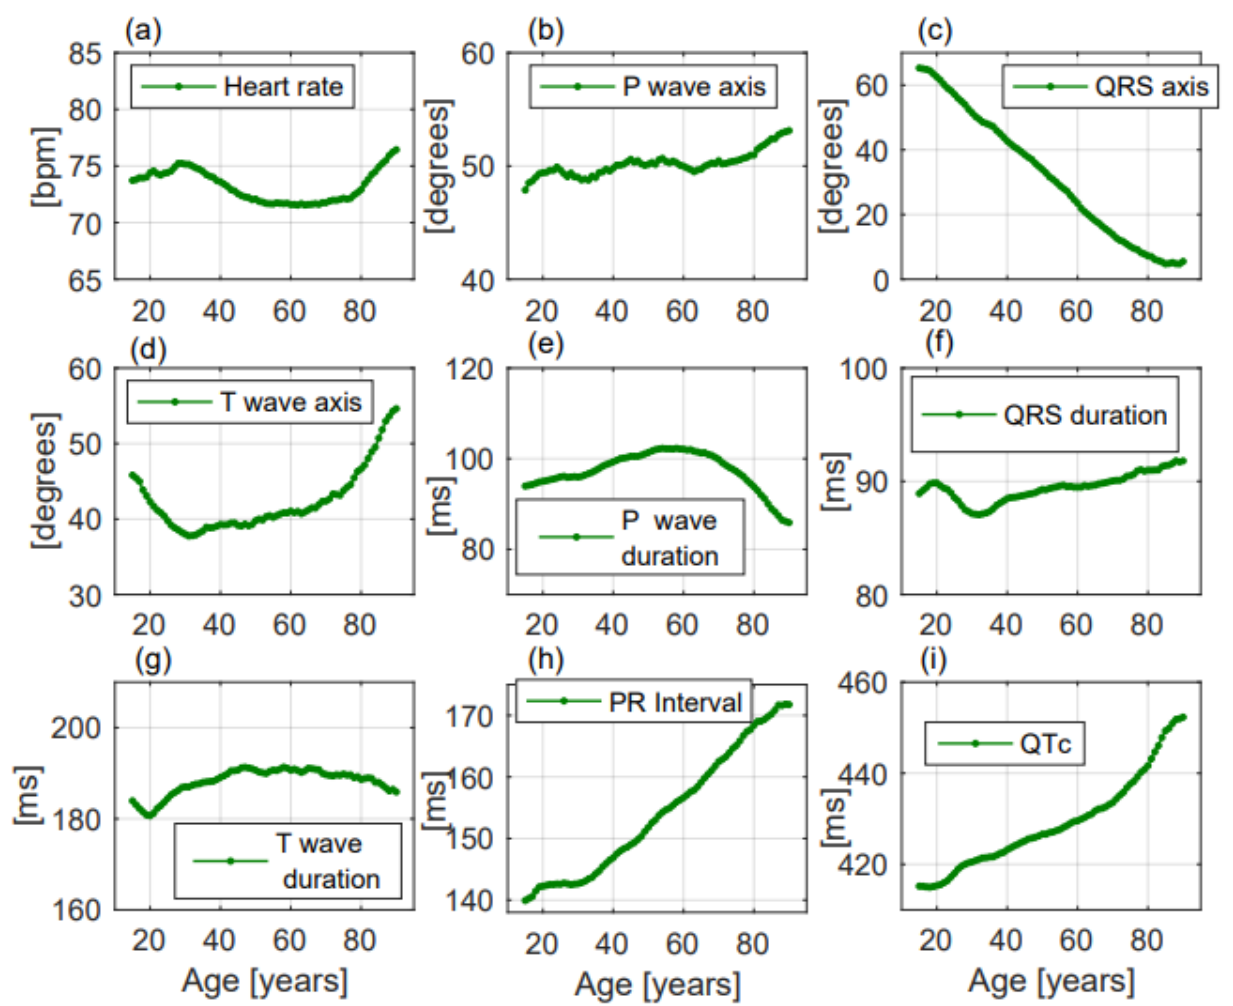
Figure 2. ECG changes with ageing of the considered parameters in the enrolled population. All the parameters ( a – i ) changed with ageing but only QRS axis ( c ), PR interval ( h ), and QTc ( i ) presented a linear change with increasing age. P wave axis slightly but significantly turned to the right, without a linear correlation ( p < 0.001, R 2 = 0.692, r = 0.832, Figure 2b). Females had greater values than males (50.8 ± 22.2 deg vs. 49.6 ± 22.6 deg, respectively, p = 0.014, Figure 3b). P wave axis turned to the right mainly in the Emergency Department facility (Table 2). QRS axis with a straight-line correlation turned to the left ( p < 0.001, R 2 = 0.991, r= − 0.996, Figure 2c). Differences between females and males were not statistically significant (30.8 ± 37.1 deg vs. 24.5 ± 41.3 deg, respectively, p = 0.177, Figure 3c). A greater shift to the left was evident in the Hospital Units group (Table